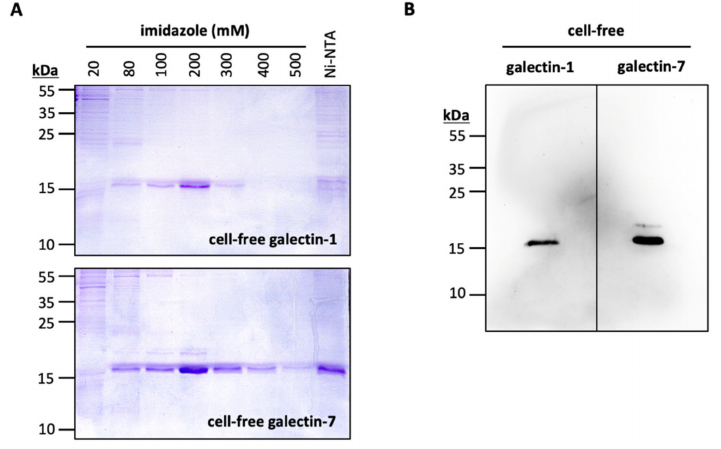
Figure 3. Cell-free production of Gal-1 and Gal-7. ( A ) Affinity-purification of His10-tagged Gal-1 and Gal-7 using nickel nitrilotriacetic acid agarose (Ni-NTA). Galectins were eluted stepwise by increasing imidazole concentrations. ( B ) Western blot of Gal-1 and Gal-7 (5 µ g per lane) using an anti penta-His primary antibody.